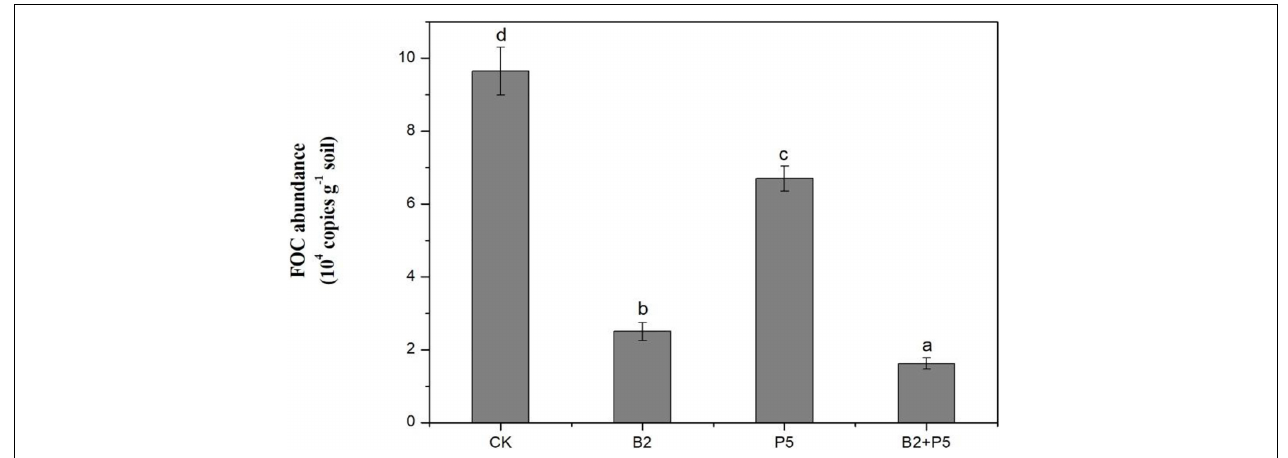
FIGURE 8 | Effect of different treatments on the population of F. oxysporum f. sp. cucumerinum (FOC) in rhizosphere soil at 60 days after transplanting. Treatments: CK, without any microbial treatment; B2, inoculation with Bacillus amyloliquefaciens B2; P5, inoculation with Pleurotus ostreatus P5; B2 + P5, co-inoculation with B. amyloliquefaciens B2 and P. ostreatus P5. Different letters above each bar indicate significant differences ( p < 0.05; Duncan’s test) among treatments. TABLE 4 | Phenolic acids in the soils of four treatments after harvesting the cucumber plant.